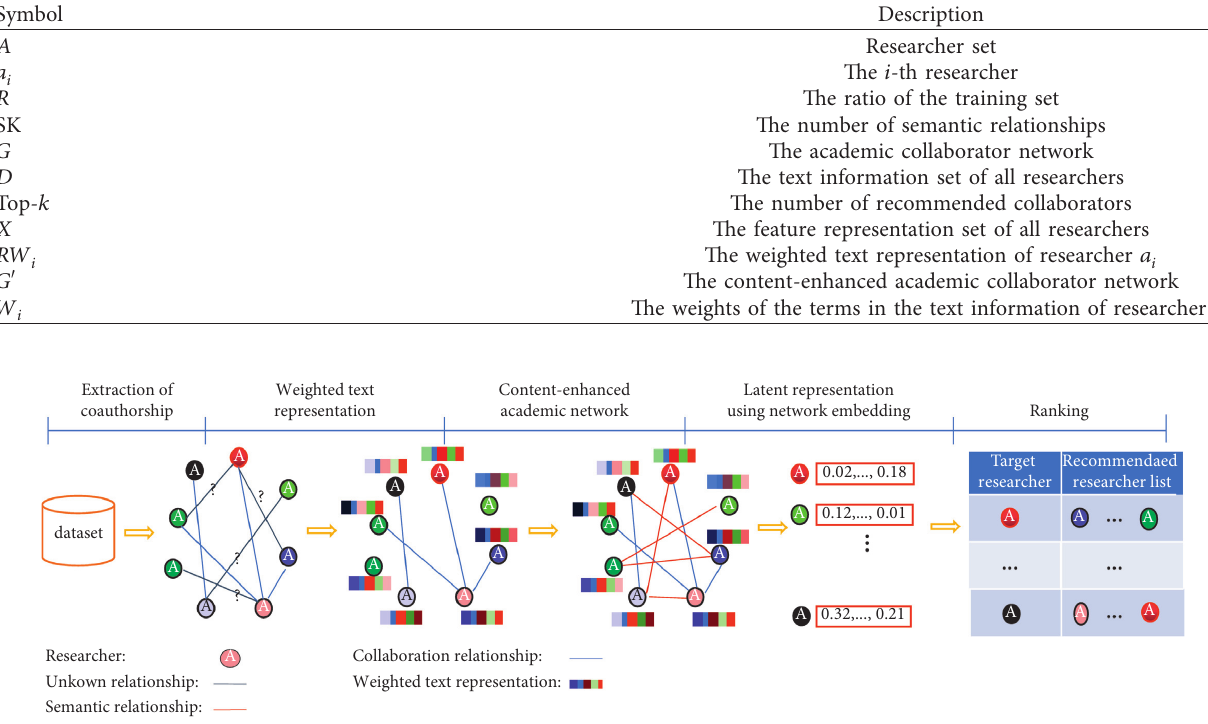
Figure 2: The framework of our proposed